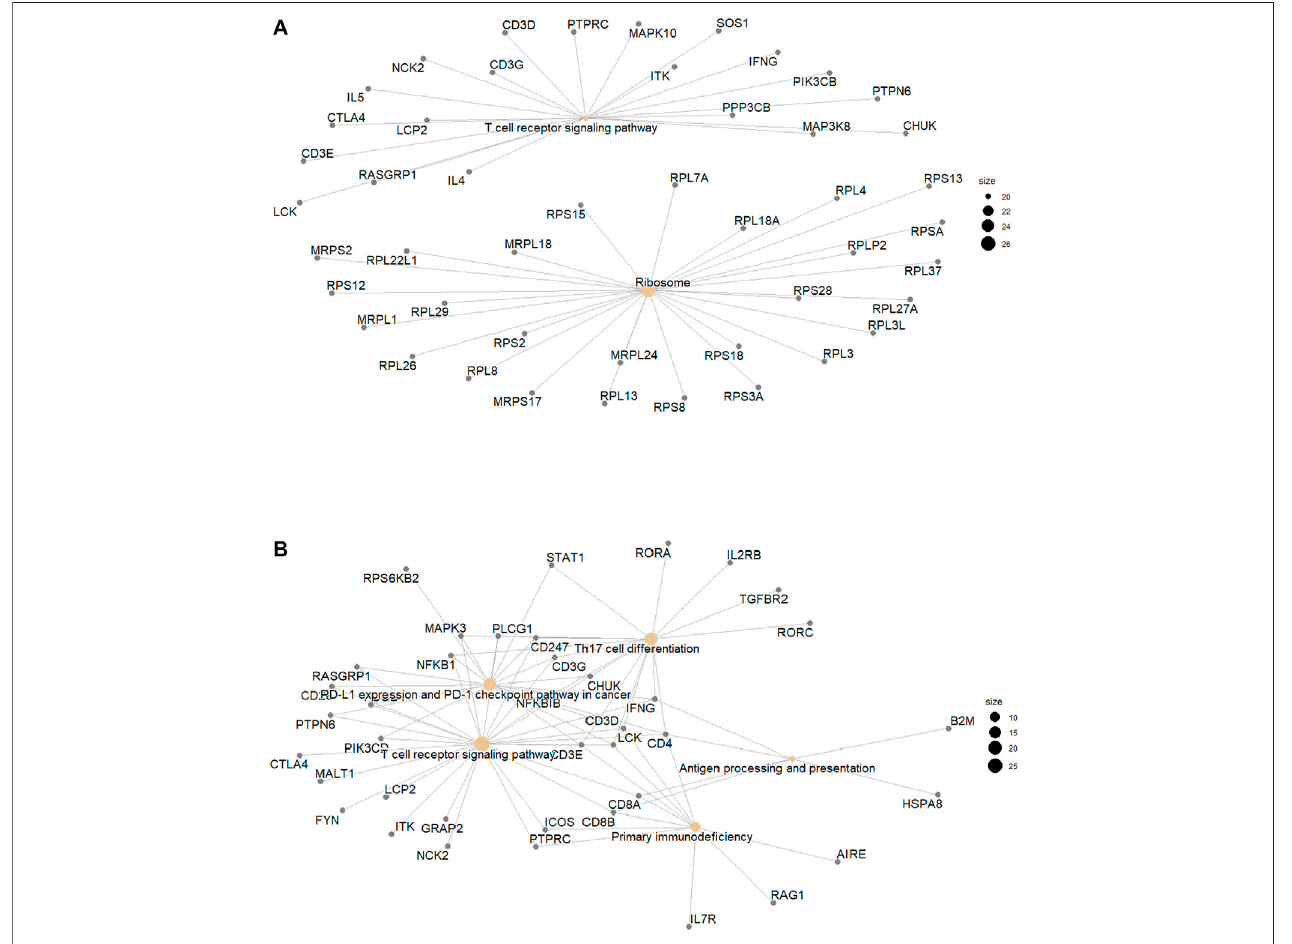
FIGURE 6 | (A) . Hypomethylated genes in CD8 T cells and (B) . Hypermethylated Genes in γδ T cells by KEGG pathways.